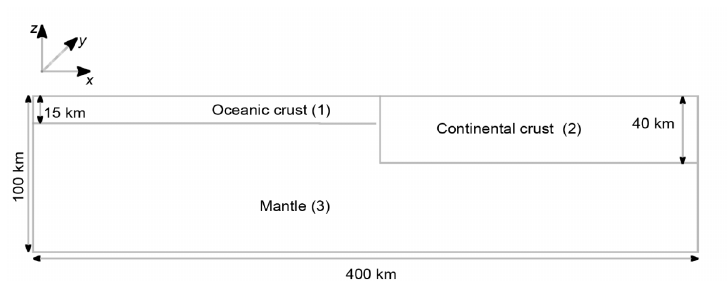
Fig. 19. Schematic representation of a border region between oceanic and continental crust.